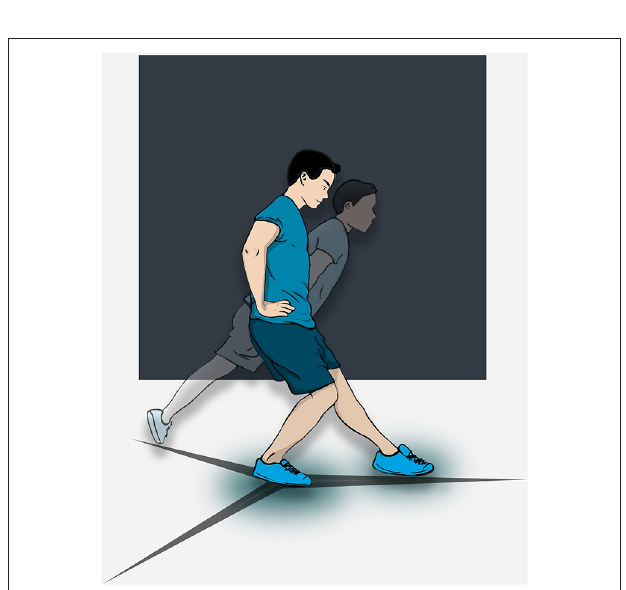
FIGURE 2 | Star excursion balance test of the right